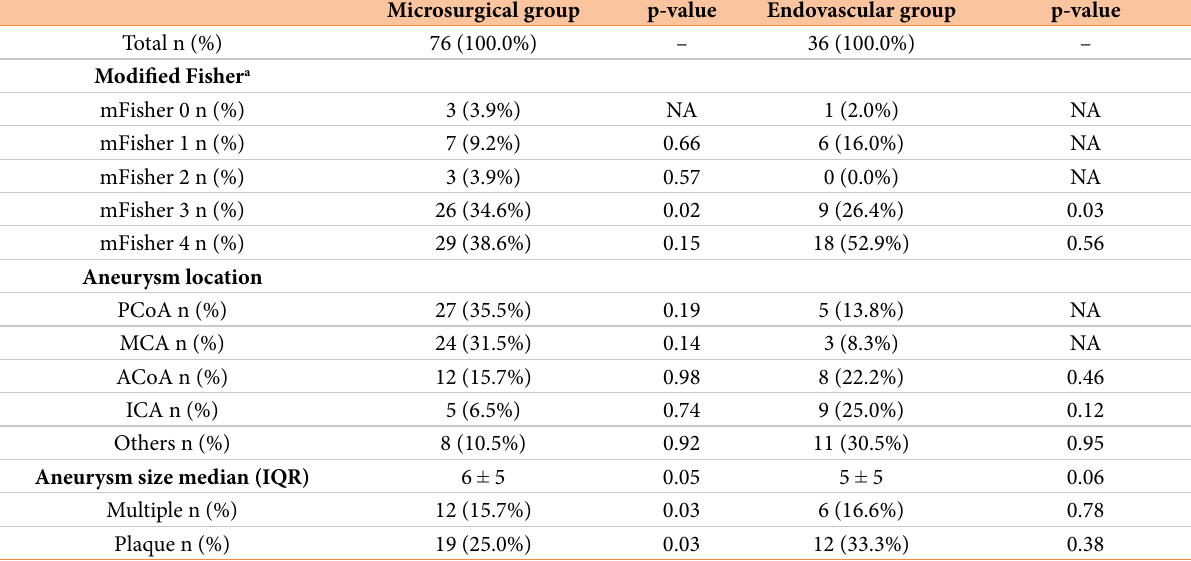
Table 3 - Radiological features and GOS in follow-up.